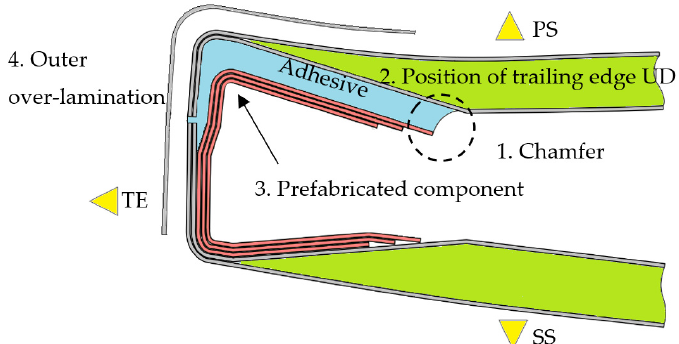
Figure 3. Schematic diagram of four structural configurations.